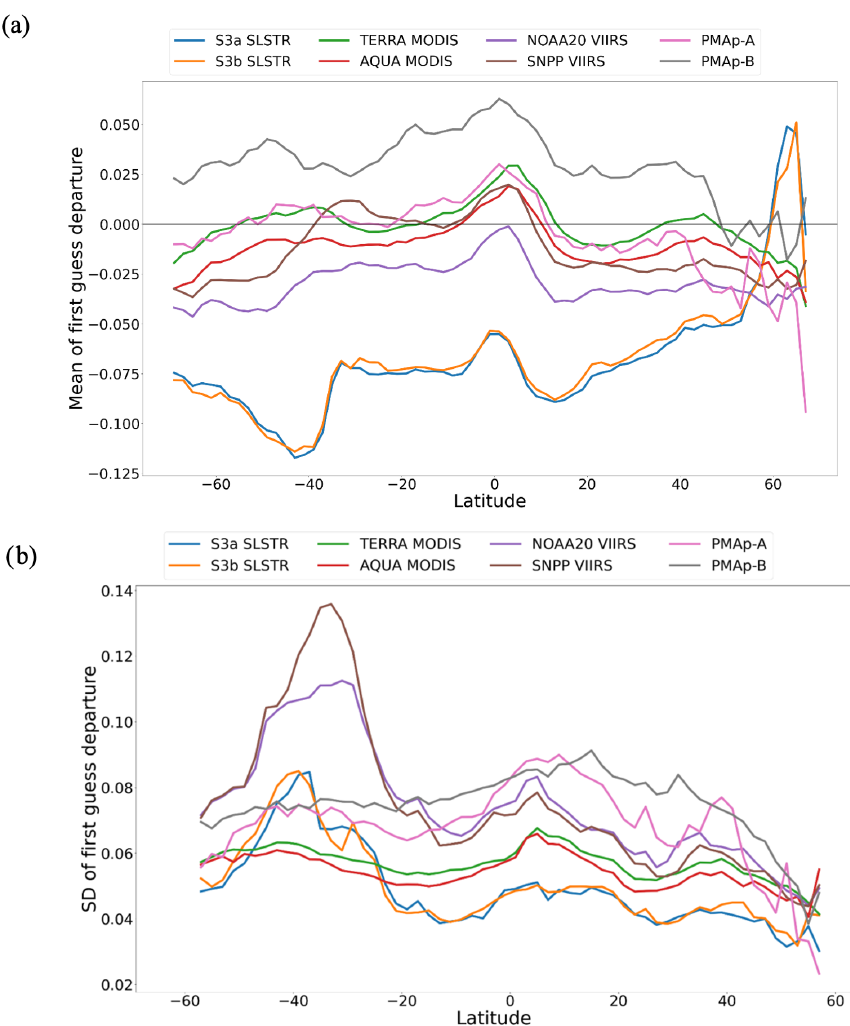
Figure 7. Latitude cross-section of the mean (a) and the SD (b) of the first-guess departure for the DJF (2019–2020) period over ocean.